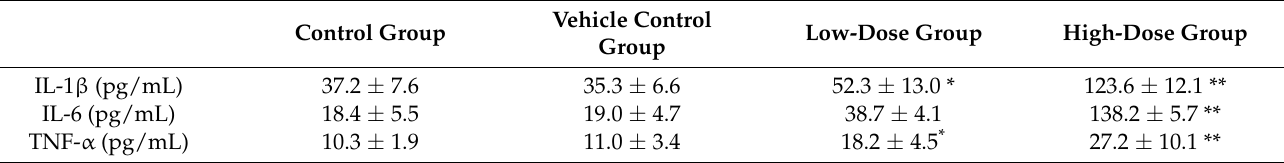
Table 2. Biochemical parameters.